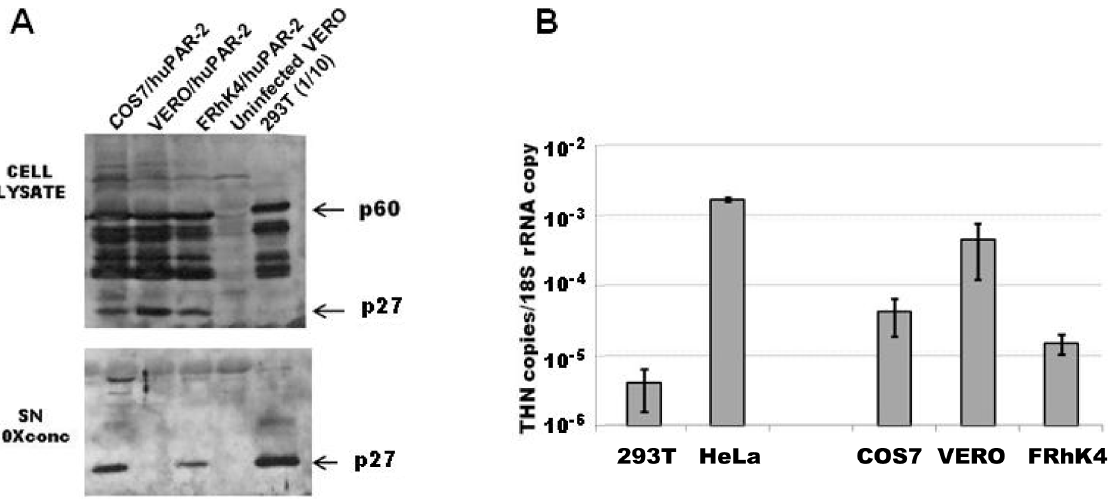
Figure 2. Inhibition of PERV release from NHP cells and expression of tetherin mRNA in NHP cell lines. A ) HuPAR-2-transduced NHP cells or wild type human 293T cells were infected with PERVA14/220. Two weeks later, 1 mL of supernatant was harvested and concentrated 10 times. The same 1 6 10 6 cells were lysed in radioimmunoprecipitation assay (RIPA) buffer. For NHP cells, one fourth of these cell lysate and supernatant samples were separated by 10% SDS-PAGE and immunoblotted using an anti-PERV CA antibody. Since PERV titer from 293T cells was more than 50 times higher than that from NHP cells, one fortieth of the 293T samples were loaded in the same gel, ten times less than that from NHP cells. The differently processed capsid forms were detected in the cell lysate (upper panel), while in the supernatant (SN) p27 was the major form (bottom panel). B ) Tetherin RNA level in RNA from NHP FRhK-4, COS7 and VERO cells and human 293T and HeLa cells lines was quantified by quantitative RT- PCR. Samples were run in triplicate. The amount of copies for each gene was extrapolated from analysis of the standard curves. Histograms represent the mean of human (left bars) and NHP (right bars) tetherin copy number normalised to one 18S rRNA copy obtained by two independent experiments ( 6 SEM).